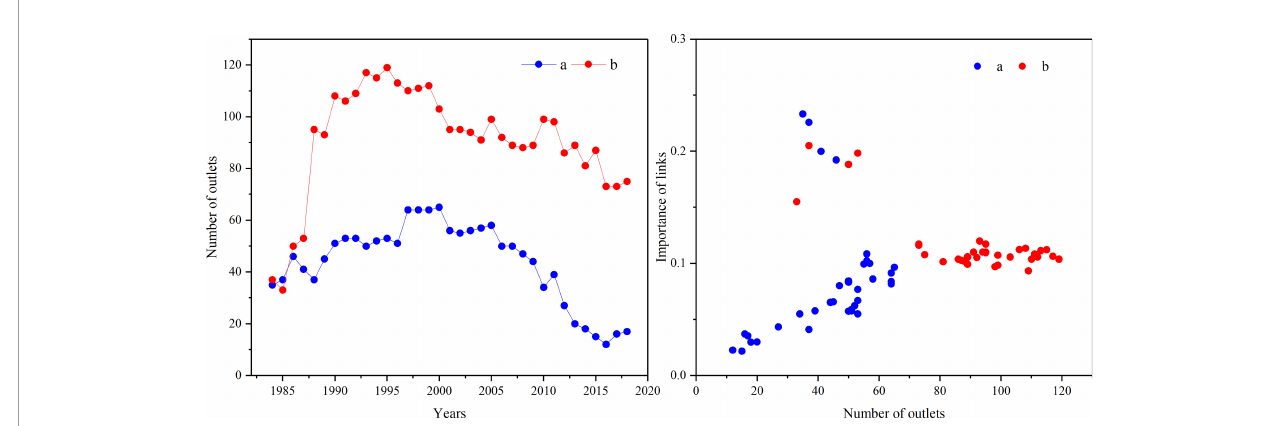
FIGURE 9 | Number of outlets and the relationship between outlets and importance of links in maintaining hydrological connectivity in the YRD (a and b represent critical impaired zone and stable zone